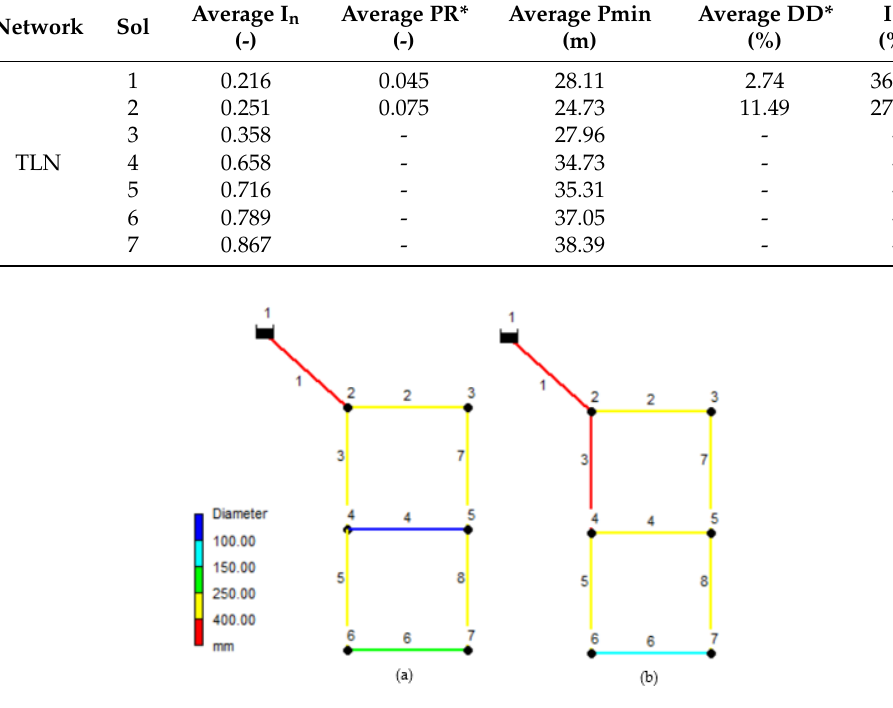
Figure 7. Pipe diameters of Solution 1 ( a ) and Solution 2 ( b ).